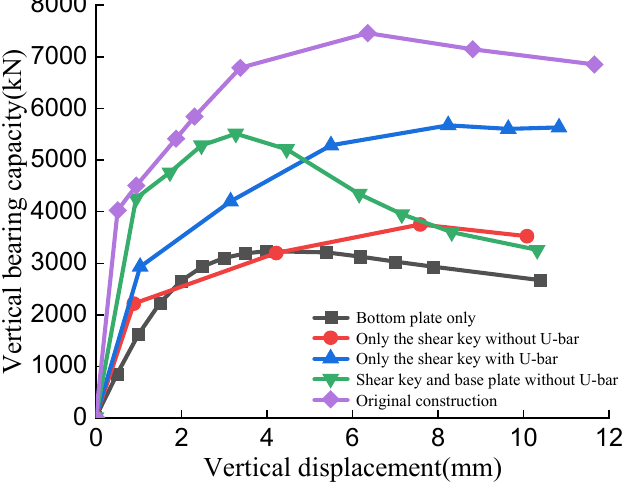
Table 4. Contribution rate of different